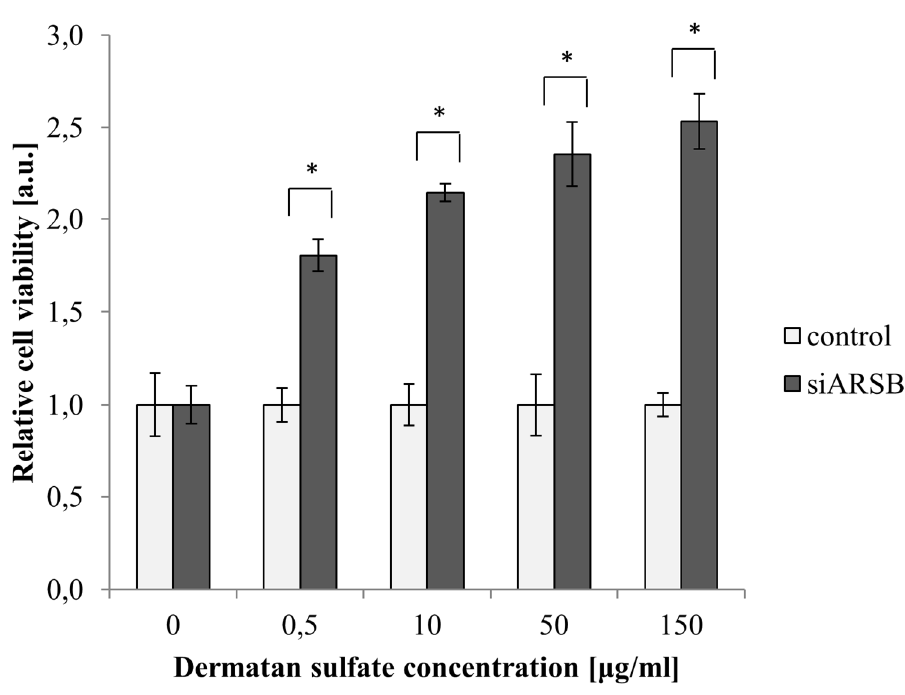
Figure 1. Influence of dermatan sulfate (DS) concentration in media on the viability of pulmonary artery smooth muscle (PASM) cells. In cells with depletion of the arylsulfatase B level (siARSB), increasing concentrations of DS result in stimulation of viability. Results are shown as mean ± SD from three biological experiments. *—statistically significant changes (compared to controls treated with non-targeting siRNA) ( p -value < 0.05). Table 1. Expression of mRNAs of glycosaminoglycan (GAG)-degrading enzymes involved in DS metabolism in human pulmonary artery endothelial (HPAEC) and PASM cells upon ARSB gene silencing. Expression of arylsulfatase B ( ARSB ) was decreased in both HPAEC and PASM cells with similar e ffi ciency. Data from microarrays experiments are shown as the change between expression in cells transfected with siARSB and non-targeting siRNA. Genes with significantly di ff erent expression are marked with an